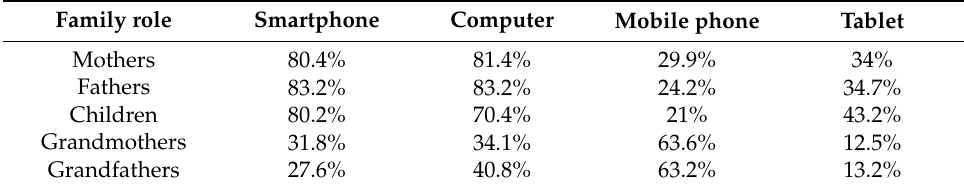
Table 1. Communication devices most commonly used by different family